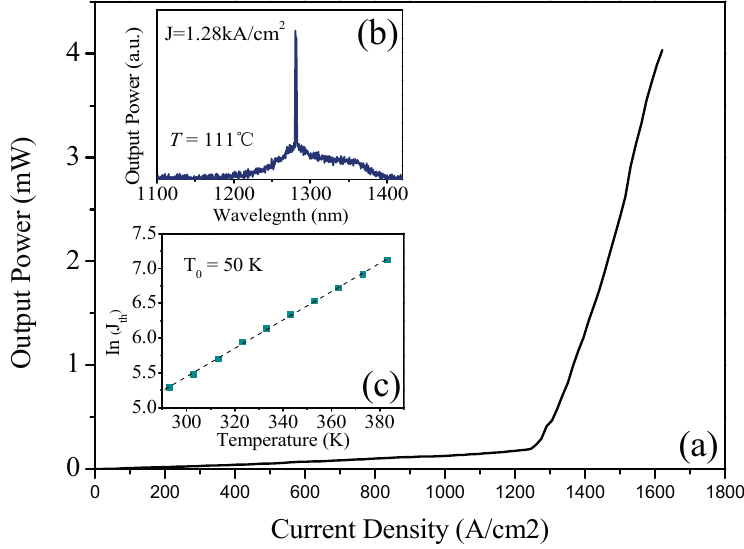
Figure 4. ( a ) Emission spectra at different injection current densities. ( b ) L-I curve of InAs QD laser on Si substrates.